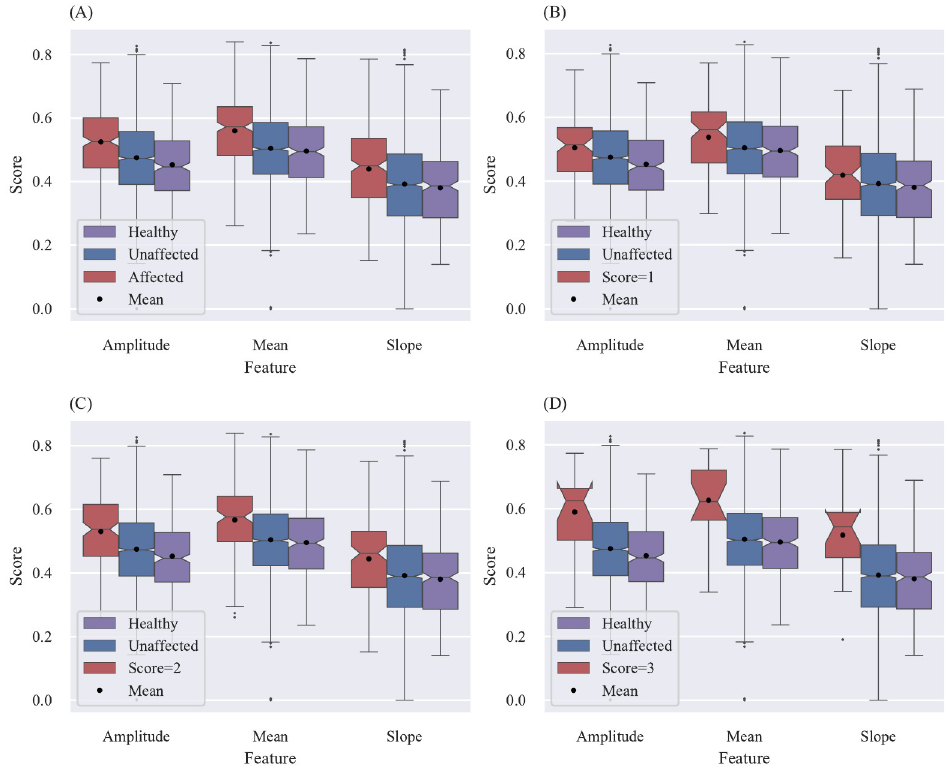
Fig 7. Comparison between the calculated scores for unaffected and affected labelled joints using FOIAS (k = 7). (A) Comparison between affected and unaffected labelled joints (sub-category: affected, k = 7). (B) Comparison between score = 1 and unaffected labelled joints (sub-category: score = 1, k = 7). (C) Comparison between score = 2 and unaffected labelled joints (sub-category: score = 2, k = 7). (D) Comparison between score = 3 and unaffected labelled joints (sub-category: score = 3, k =